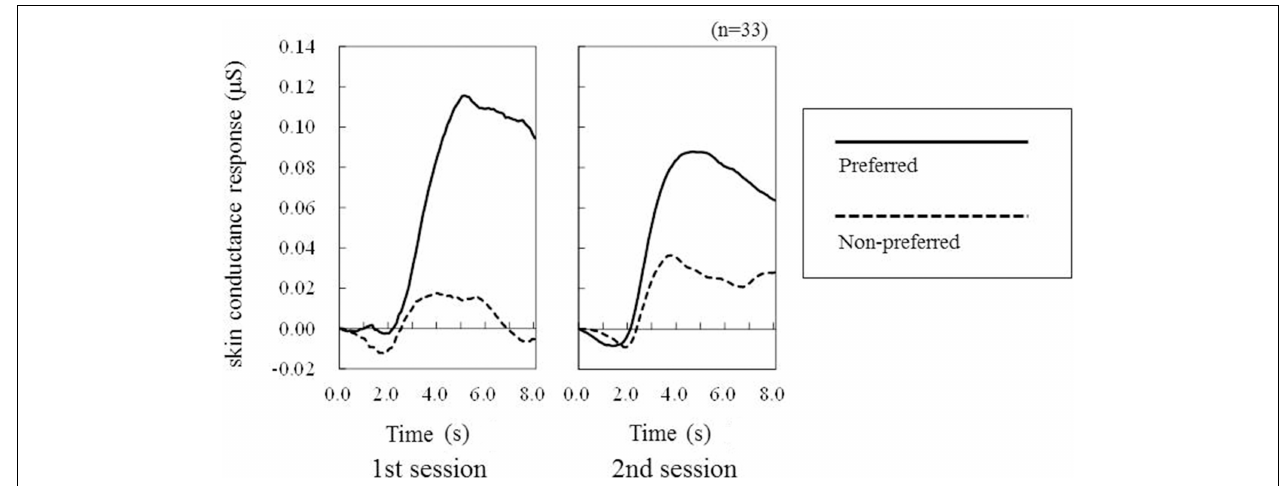
FIGURE 2 | Grand averaged SCR waveforms elicited by preferred products and non-preferred